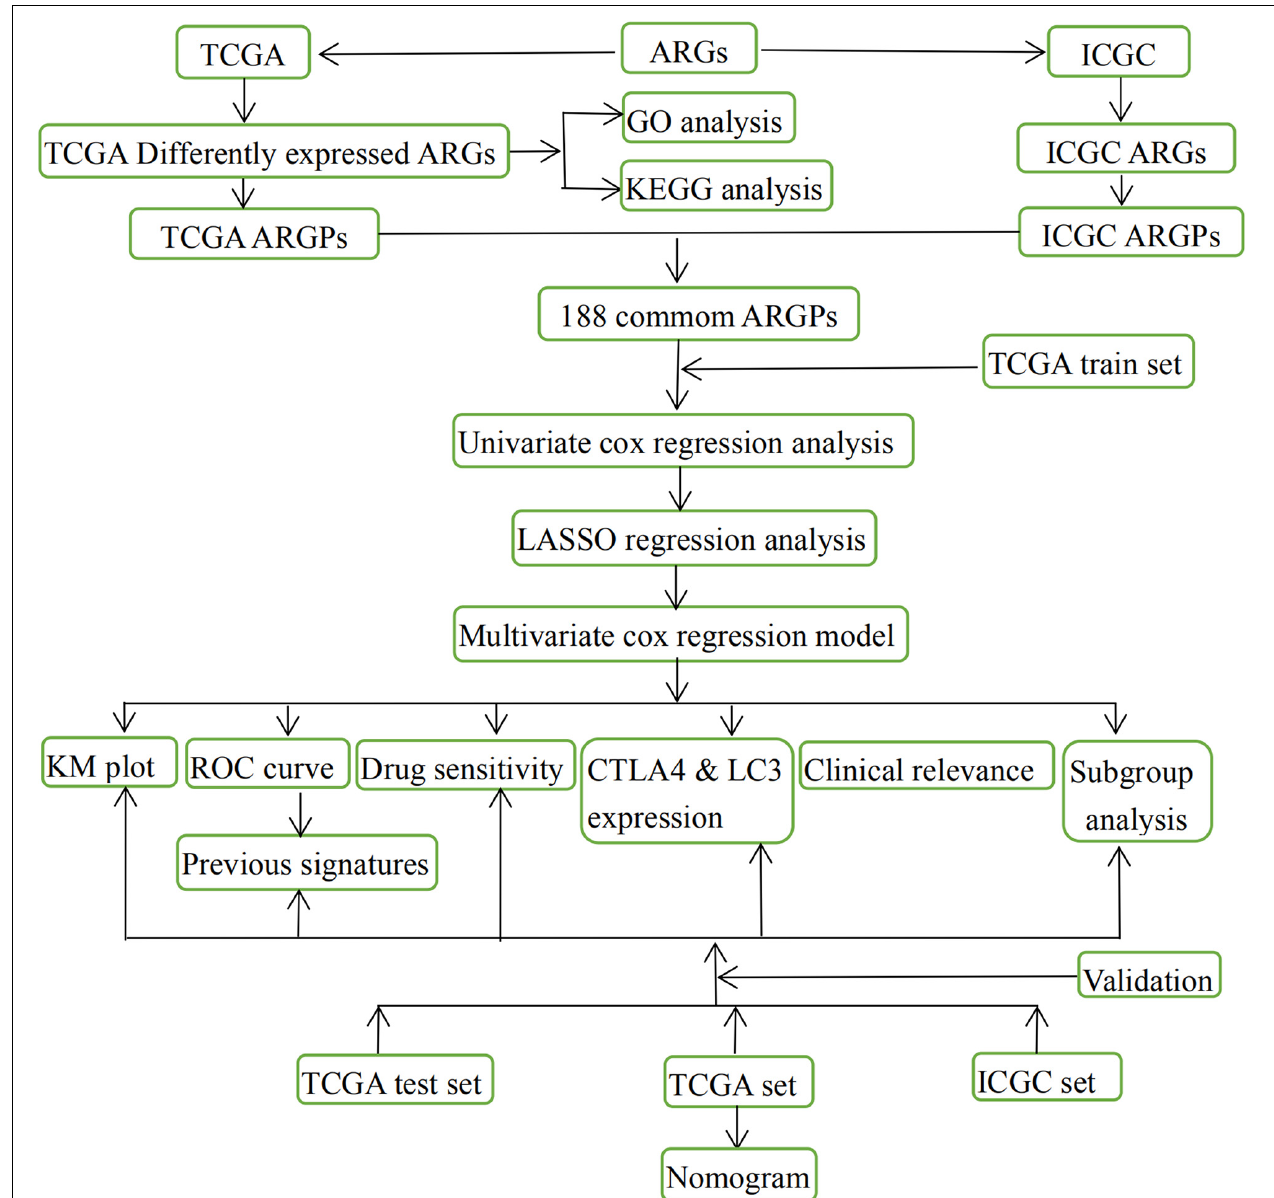
FIGURE 1 | Entire workflow of the present